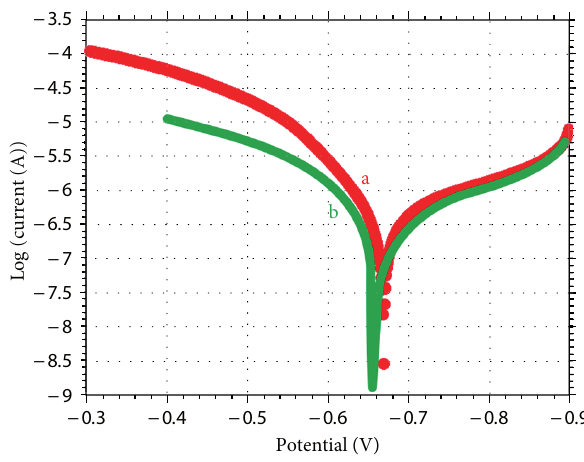
T 3: Corrosion rates (CRs) of carbon steel immersed in well water in the presence and absence of inhibitor system at various concentrations and the inhibition efficiencies (IEs) obtained by weight loss method.